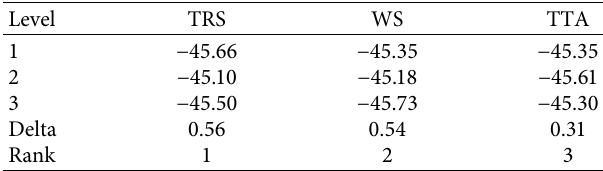
Figure 12: Optical microstructure image of the L22 specimen. (a) Al5456 base metal. (b) Al6262 base metal. (c) HAZ in Al5456. (d) HAZ in Al6262. (e) Weld nugget. Table 6: SN ratio outcomes.